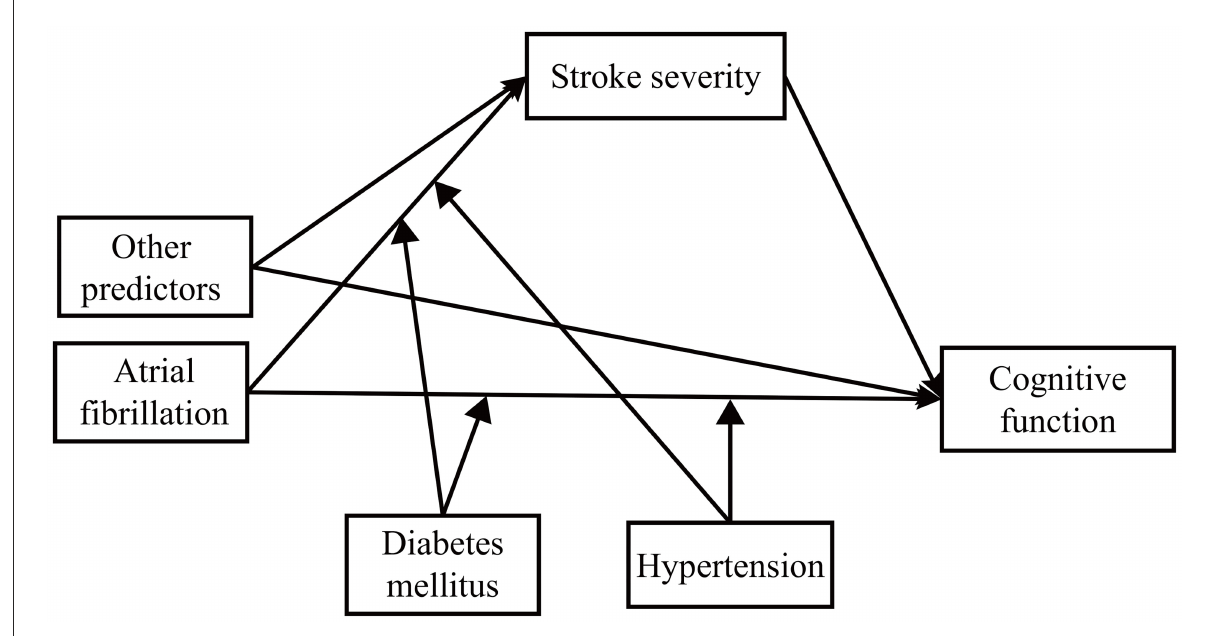
FIGURE1 The theoretical framework model gram. We examined the moderating effect on atrial fibrillation, vascular disease, and previous stroke separately.